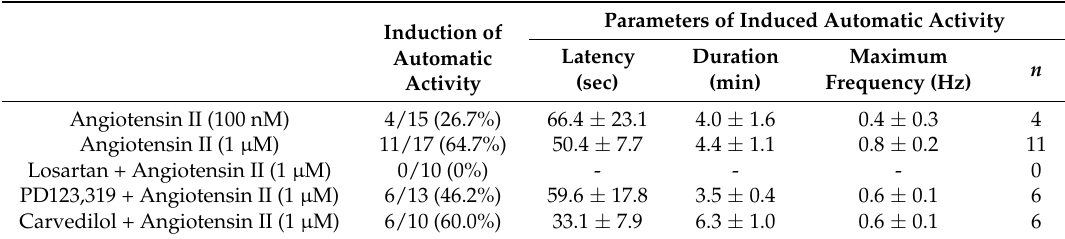
Figure 1. Induction of automatic contractile activity by angiotensin II in pulmonary vein tissue preparations. ( A ) Typical contractile records on application of 100 nM angiotensin II (a), 1 µ M angiotensin II (b), 1 µ M angiotensin II in the presence of 10 µ M losartan (c), 1 µ M angiotensin II in the presence of 10 µ M PD123,319 (d) and 1 µ M angiotensin II in the presence of 100 nM carvedilol (e); ( B ) Summarized time course of the frequency of contraction induced by 100 nM angiotensin II (squares), and 1 µ M angiotensin II (circles). The 0 min on the time scale indicates the onset of contractile activity. Symbols and vertical bars indicate the mean ± S.E.M. from 4 and 11 experiments, respectively; ( C ) Summarized results of the rate of induction of automatic contractions. Columns indicate the rate of induction 10 to 17 experiments. Asterisks indicate significant difference from the control ( p < 0.05) as evaluated by the Fisher’s exact test. Table 1. Induction of automatic contractile activity by angiotensin II.